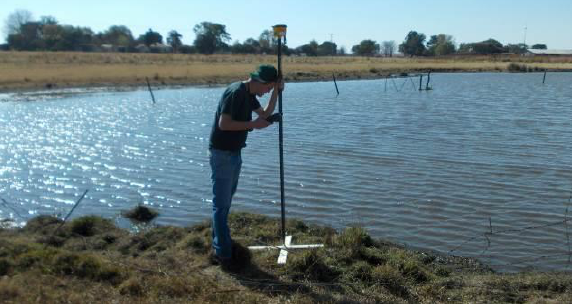
Figure 1. Placement of the ground control markers.